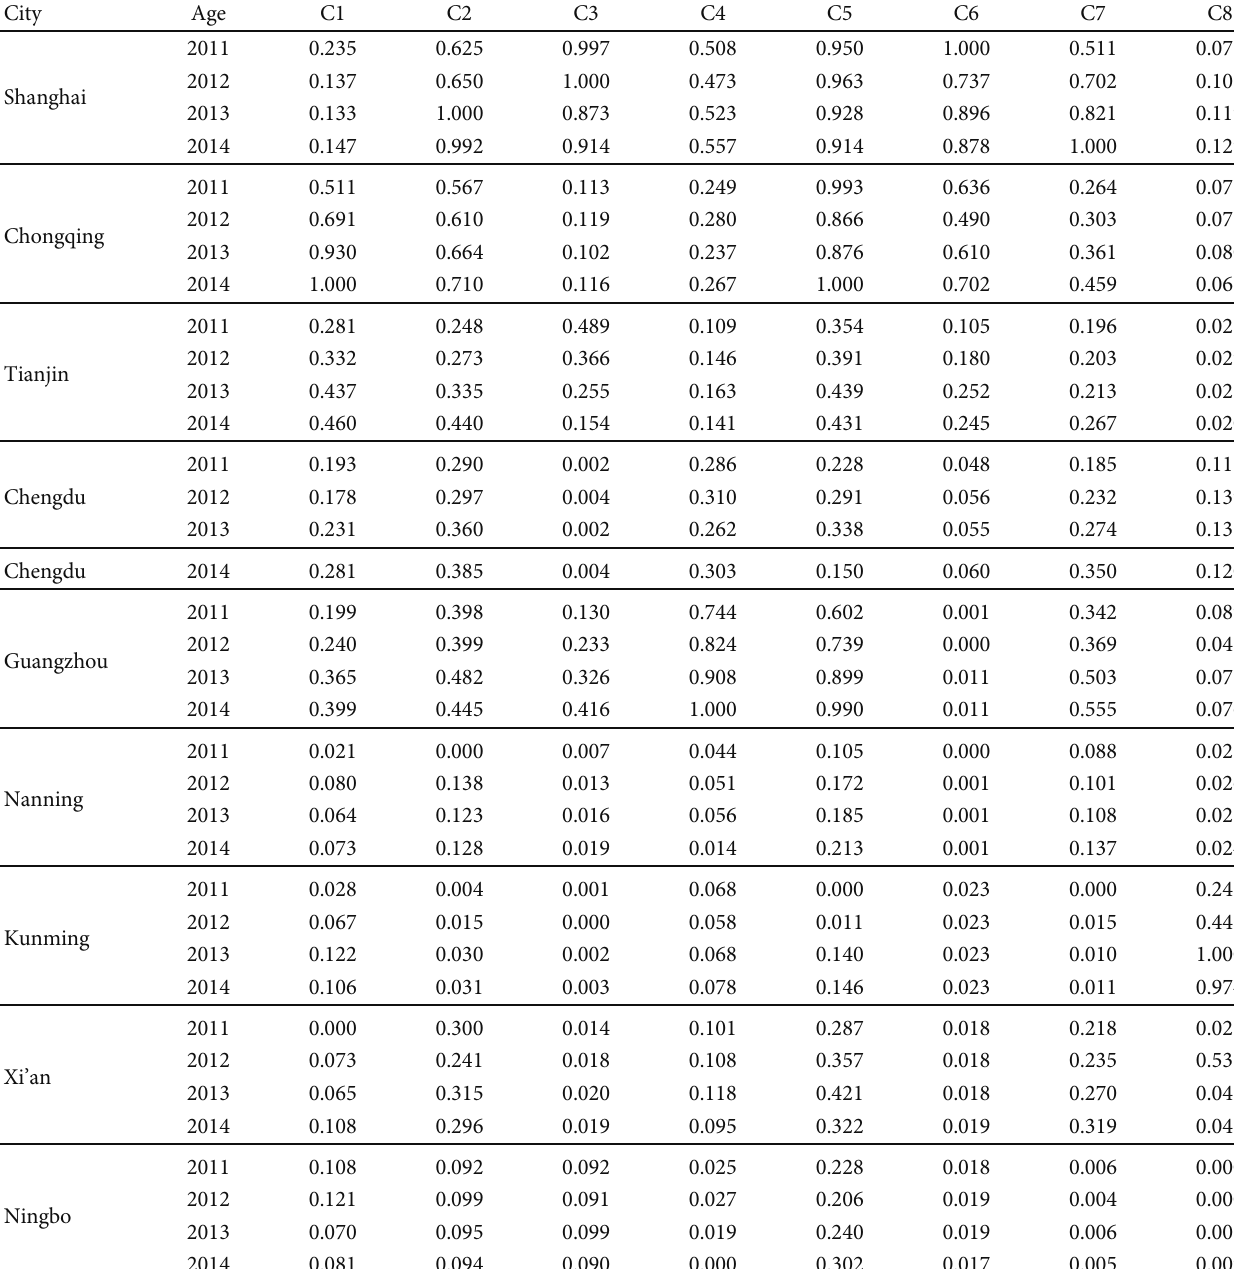
Table 4: Transpose matrix of 8-dimensional compound fuzzy